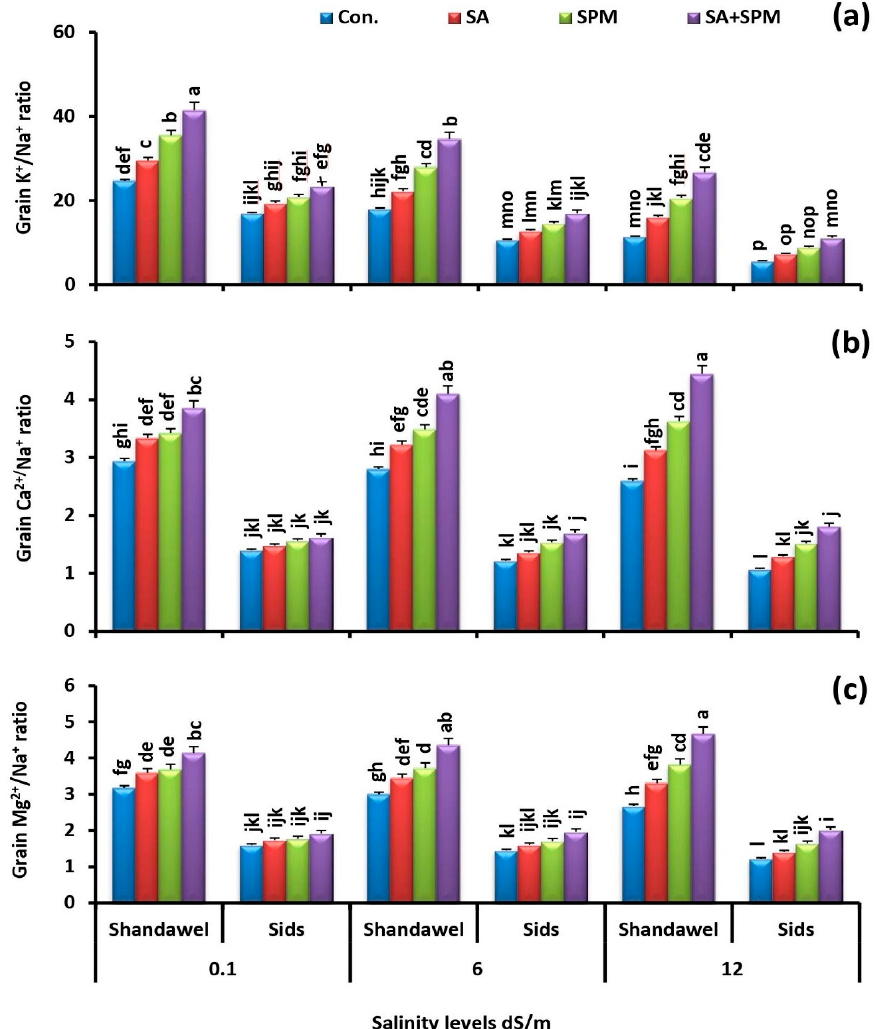
Figure 8. Influence of salicylic acid (SA; 100 mgL − 1 ) and/or spermine (SPM; 30 mgL − 1 ) on the ratio of ( a ) K + /Na + , ( b ) Ca 2+ /Na + , and ( c ) Mg 2+ /Na + in grains of two wheat cultivars (Shandawel 1 and Sids 14) grown under 0.1, 6, and 12 dS m − 1 salinity levels. Data are mean of four replicates (n =